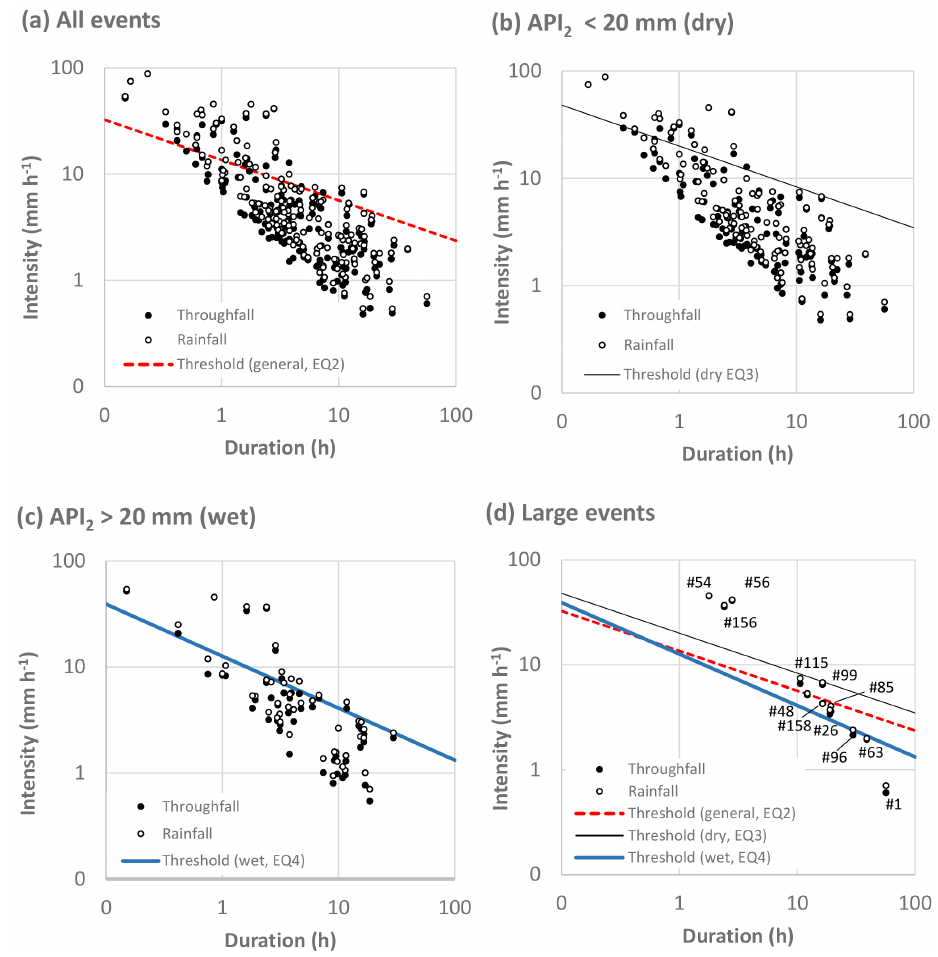
Figure 7. Comparison of event rainfall (open circles) and throughfall (solid circles) intensity–duration relationships with modified Caine thresholds for shallow landslide initiation. (a) All 167 events are plotted against the general threshold (Eq. 2). (b) Events associated with dry conditions (API 2 <20mm) are plotted against the threshold defined by Eq. (3). (c) Events associated with wet conditions (API 2 ≥ 20mm) are plotted against the threshold defined by Eq. (4). (d) The 12 largest storms summarized in Table 2 are plotted against all thresholds (Eqs. 2–4). Some apparently missing throughfall data points plot behind their paired corresponding rainfall